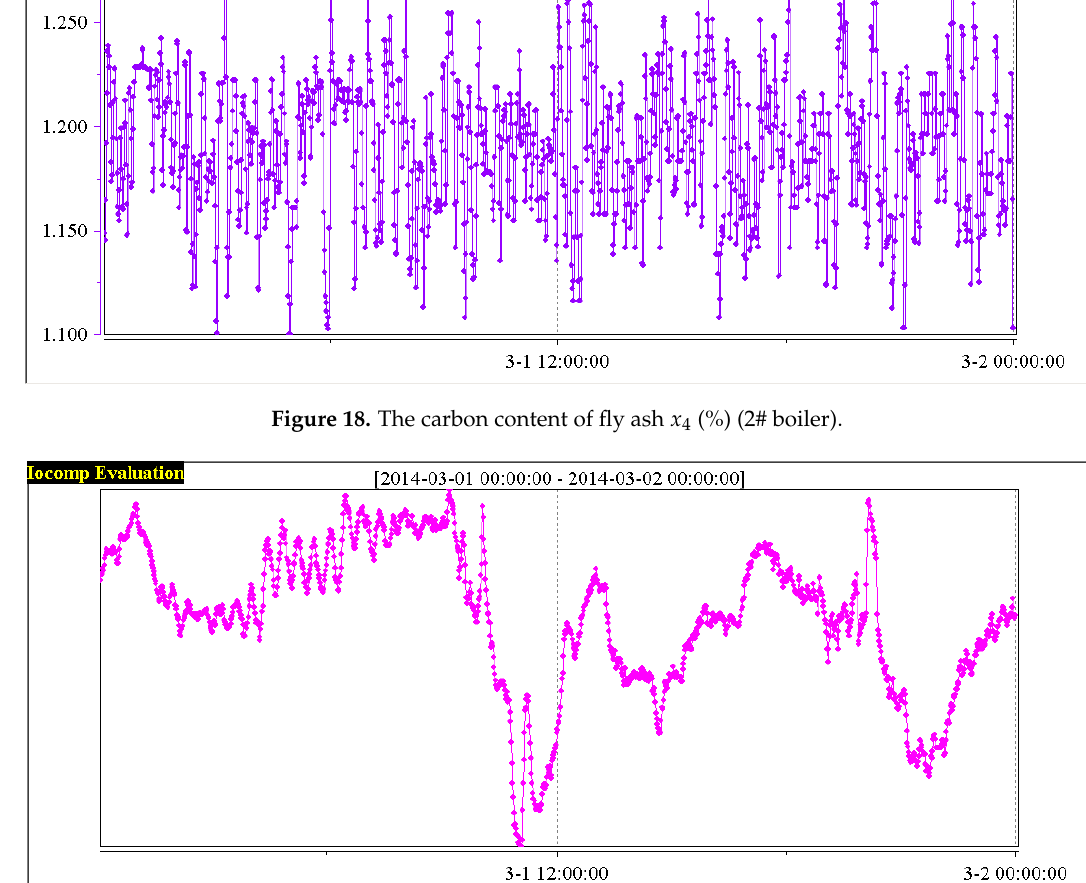
Figure 19. The leakage rate of air preheater